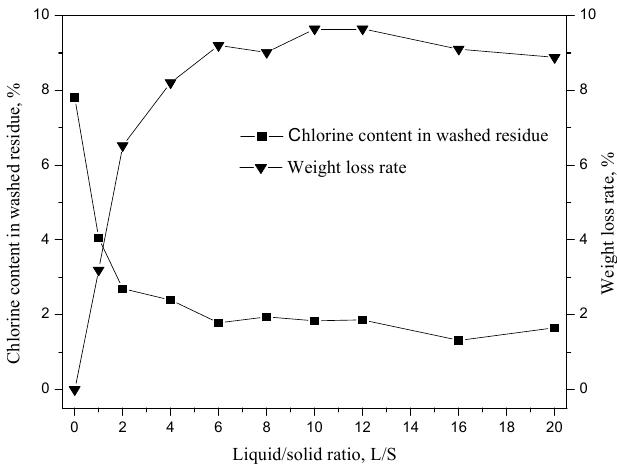
Figure 2. The evolution of chlorine content in washed residue and weight loss vs. L/S.